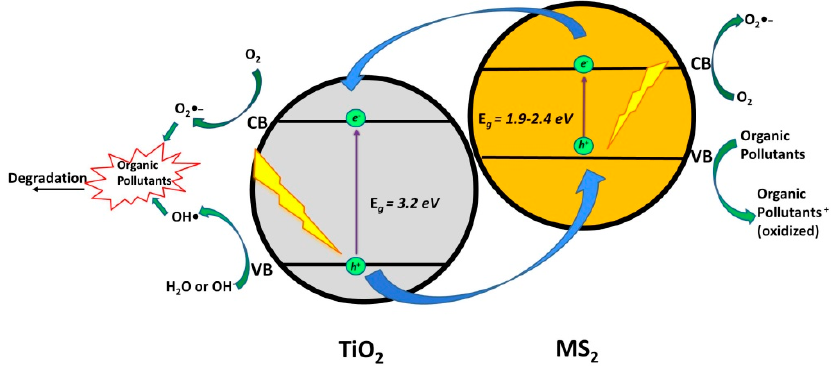
Figure 7. General photocatalytic degradation mechanism over TiO 2 / MS (M = Cd or Cu) or MS 2 (M = Mo and Sn) composite.